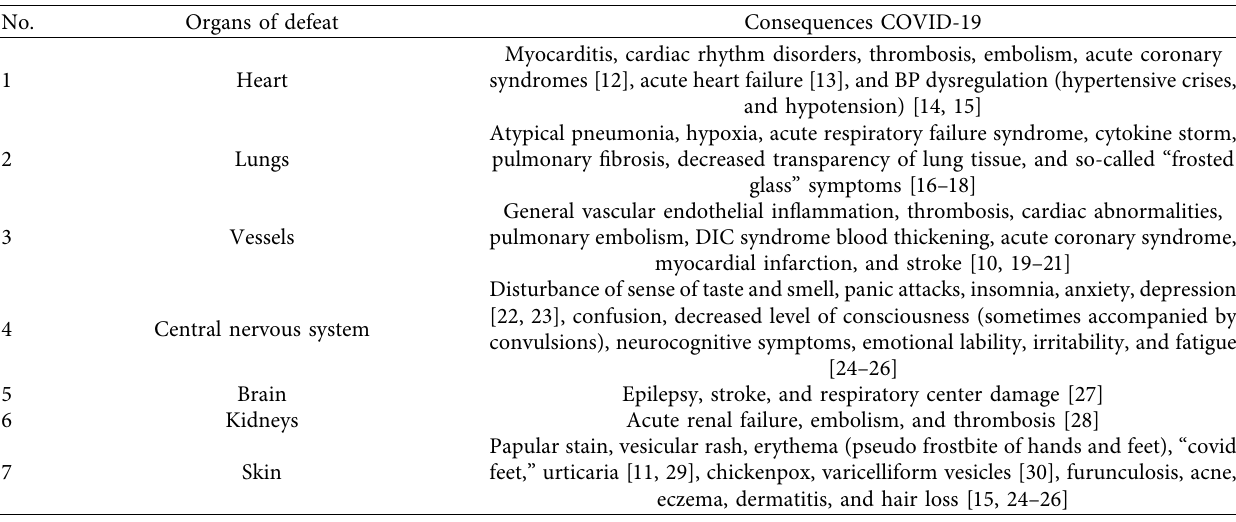
Table 1: Te main infuence of COVID-19 on